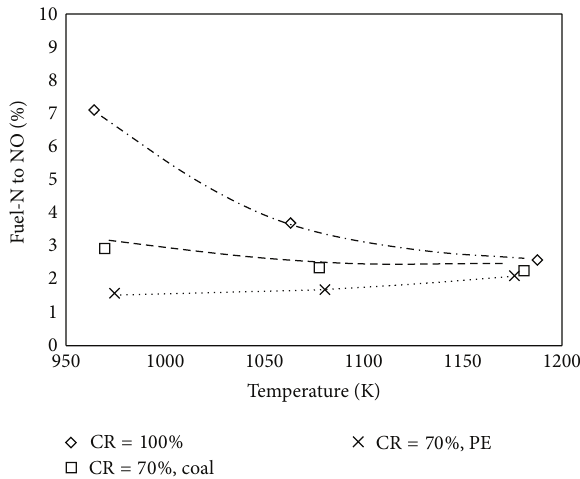
Figure 3: Influence of furnace temperature on conversion ratio of fuel-N to N 2 O.